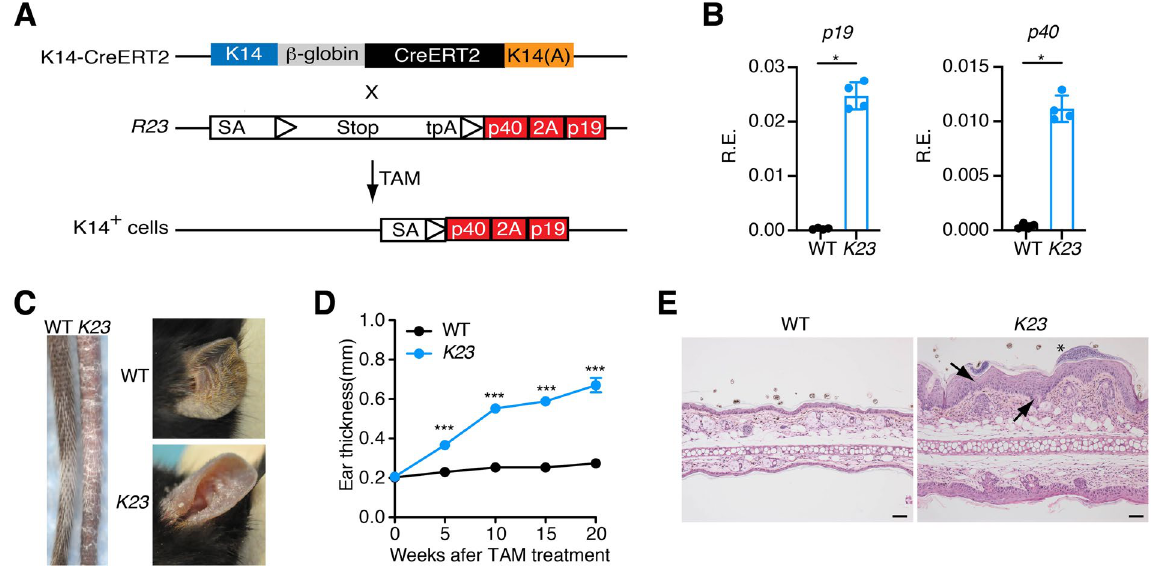
Figure 1. Transgenic expression of IL-23 by keratinocytes causes skin inflammation. ( A ) Scheme for generation of K23 mice. R23 mice were crossed with K14 CreERT2 mice to generate K23 mice. ( B ) Relative expression of p19 and p40 mRNA in the ears of WT and K23 mice 8 weeks after TAM treatment (n = 4/group). * p < 0.05 by nonparametric Mann-Whitney test. ( C ) Representative macroscopic view of tails and ears of WT and K23 mice after TAM treatment. K23 mice treated with TAM showed inflammation in the tail and ears (n = 37 mice). ( D ) Quantification of the ear thickness after TAM treatment (n = 10–23 mice/time point). *** p < 0.001 compared with WT mice at the same time point by nonparametric Mann-Whitney test. ( E ) Representative H&E section of an ear of WT and K23 mice 6 weeks after TAM treatment. Notice the presence of parakeratosis